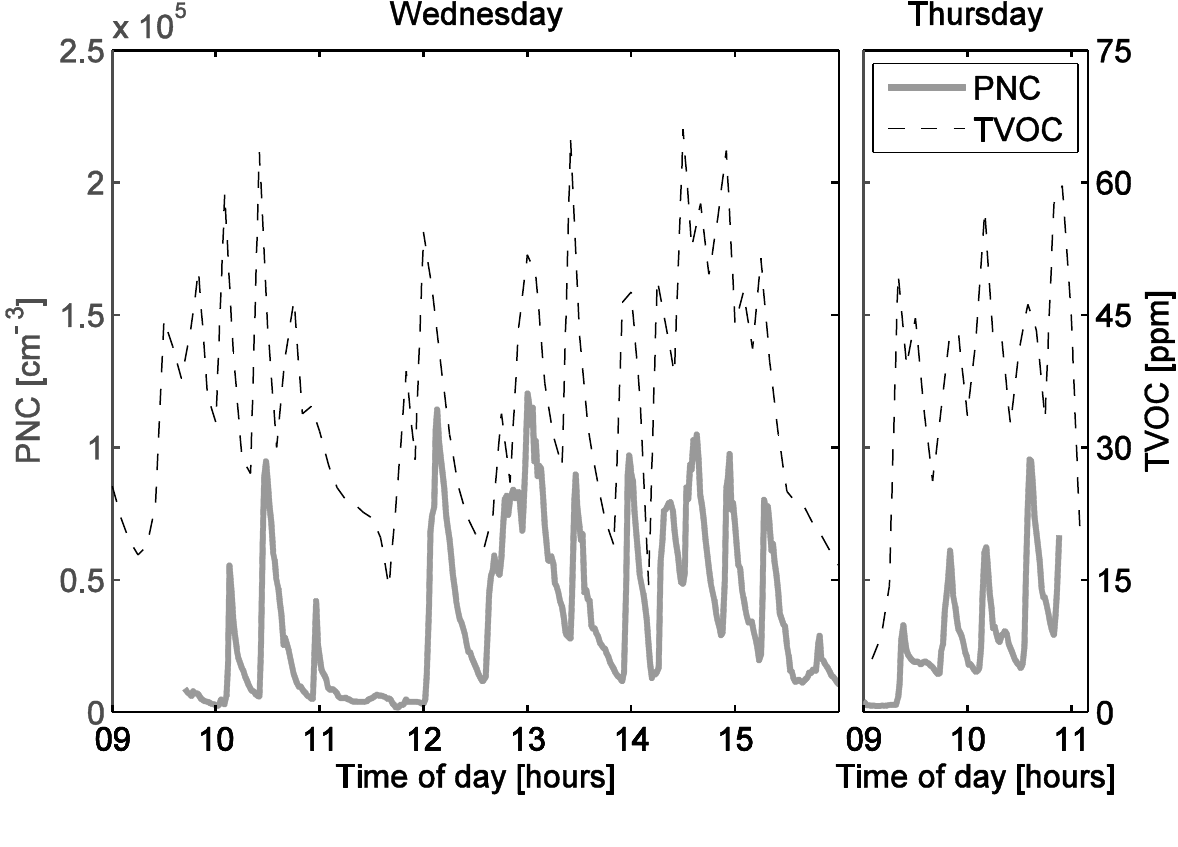
Figure 6. Particle number concentrations and TVOC in the molding room. The two subfigures have same concentration scales both for particle number concentration and